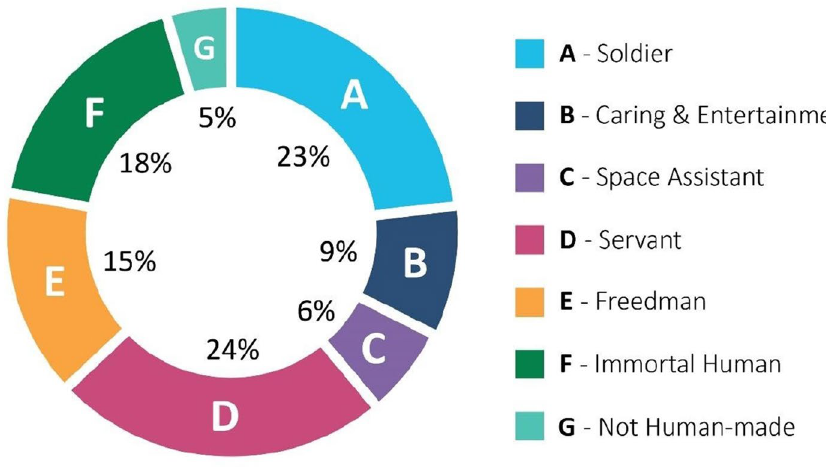
Fig. 2 The percentage of inves- tigated movies in each fictional robots’ classification